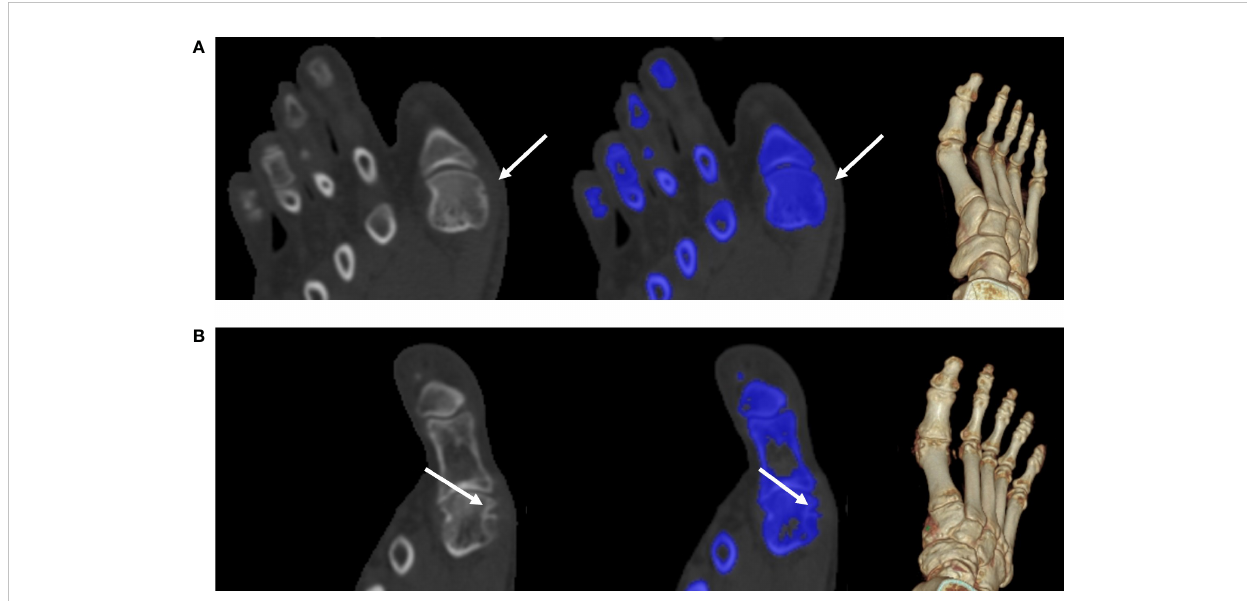
FIGURE 5 Tiny bone erosion on the medial side of the metatarsal head. (A) A 31-year-old man in the non-UD group presented with knee joint ache for two days; his serum urate level was 332 m mol/L. He underwent intermittent medication to control the acute fl are, though his response to medication this time was not well. Bone erosion (white arrow) had a score of 1. A 140-kV CT image showing bone erosion (white arrow) (left); color-coded 50% mixed-energy CT image (middle) showing bone erosion (white arrow) and bone structure (blue); and surface-rendered three-dimensional CT image (right). (B) A 58-year-old man in the non-UD group presented with chronic gout for approximately 22 years (serum urate, 568 m mol/L). The patient was not adherent to uric acid-lowering medications. Bone erosion (arrow) had a score of 2. A 140-kV CT image showing bone erosion (white arrow) (left); color-coded 50% mixed-energy CT image (middle) showing bone erosion (white arrow) and bone structure (blue); surface-rendered 3D CT image (right). CT, computed tomography; UD, urate deposition.